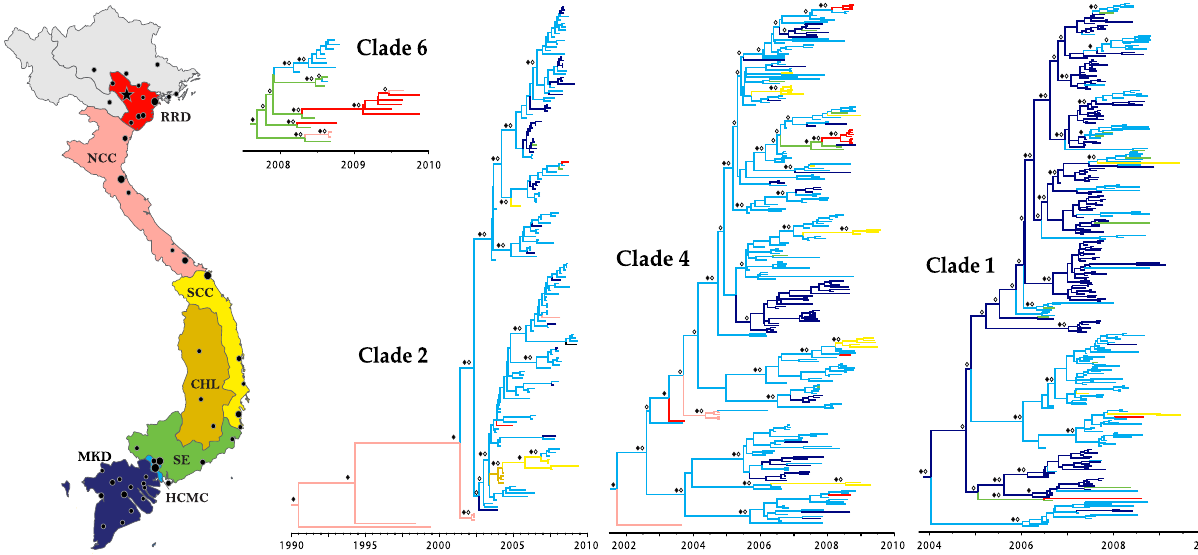
Figure 2. Local phylogeography in a sample of Vietnamese DENV-1 clades. Maximum clade credibility (MCC) trees showing phylogeographic relationships among Vietnamese DENV-1 E gene sequences. Branch colors correspond to locations indicated in the map of Viet Nam. Closed diamonds indicate posterior probability support $ 0.85 on relevant nodes. Open diamonds indicate ancestral location state probability $ 0.85. Black circles on the map indicate cities with population size greater than 100,000, with the size of the circle representing the relative population size. The black star indicates Viet Nam’s capital city, Hanoi. doi:10.1371/journal.pntd.0002581.g002 PLOS Neglected Tropical Diseases |